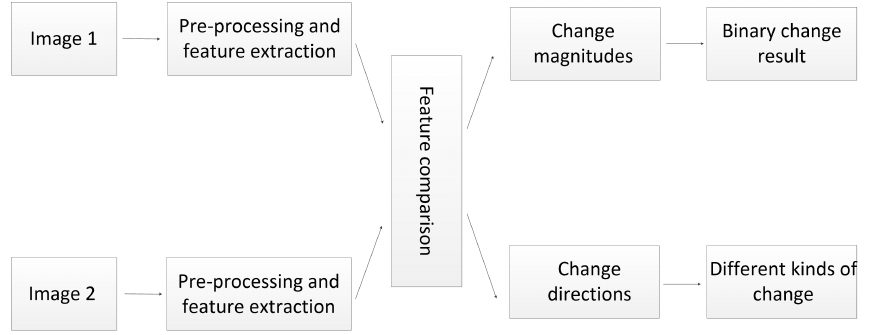
Figure 3. Flow diagram of